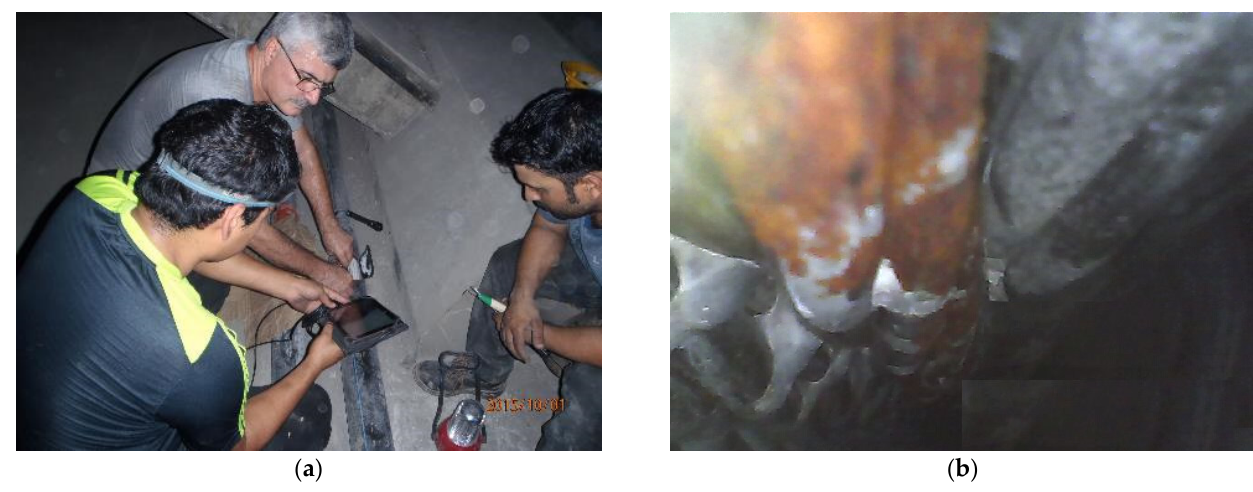
Figure 15. Activities during the second stage of two-stage inspection. ( a ) application of video-bo- rescope, ( b ) a sample of steel photo captured by borescope.